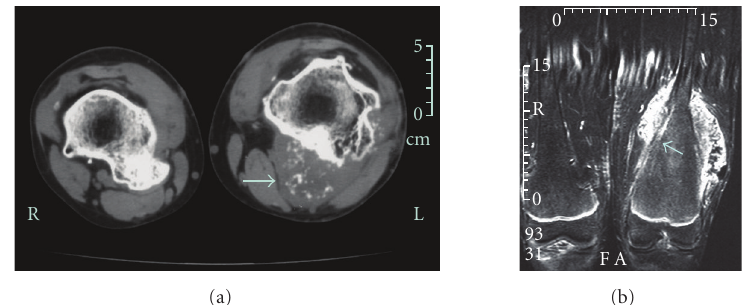
Figure 5: (a) CT scan includes both distal femurs prior to excision of osteochondromas. Contrast the benign appearance of the osteochondroma on the patient’s right femur to the thickened cartilage cap with stippling on the left (arrow). (b) MRI includes the left distal femur after resection of the benign posteromedial osteochondroma and biopsy of the posterior chondrosarcoma, with the thickened cartilage cap and invasion of femoral cortex (arrow) evident.